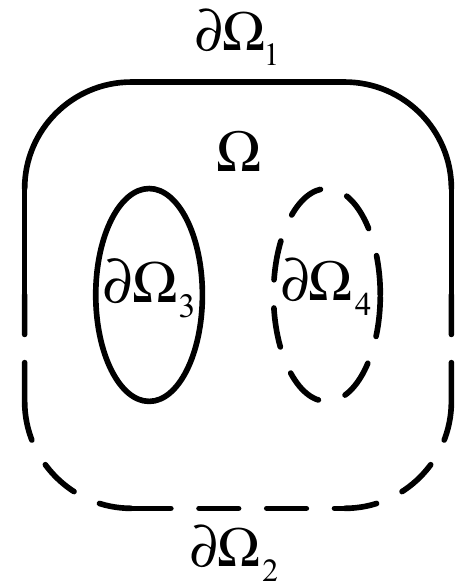
Figure 1. Schematic diagram of a multiply connected inverse problem.